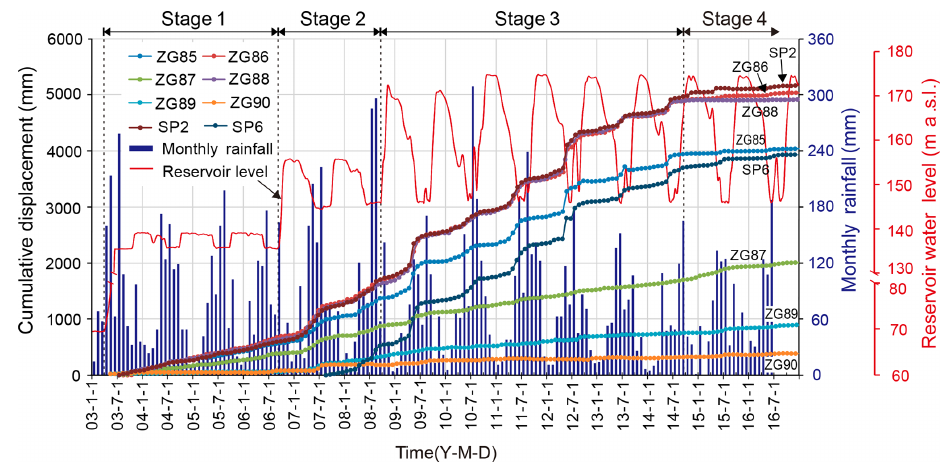
Figure 9. Monitoring data for Shuping landslide from 2003 to 2016.